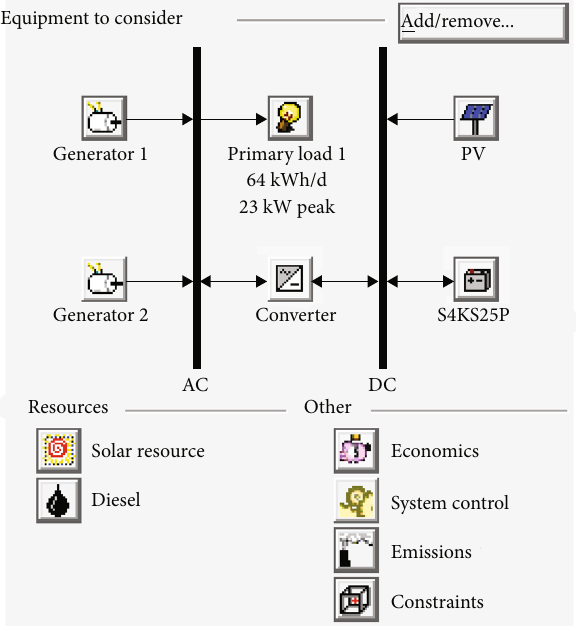
Figure 8: Typical hybrid PV/diesel system con fi